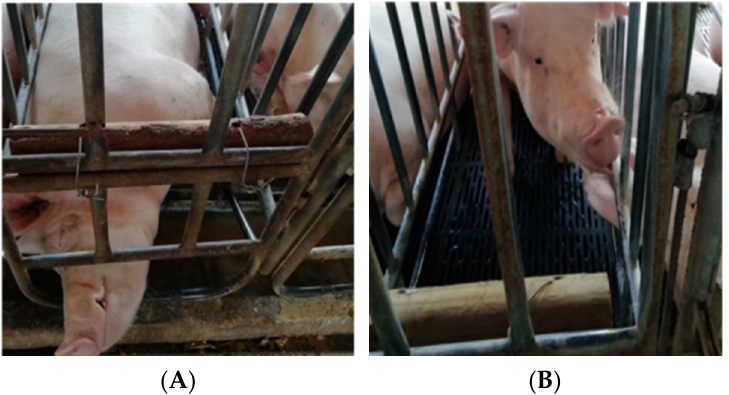
Figure 2. Enrichment items for pregnant sows in confinement stalls: ( A ) pine and ( B ) scented wood.